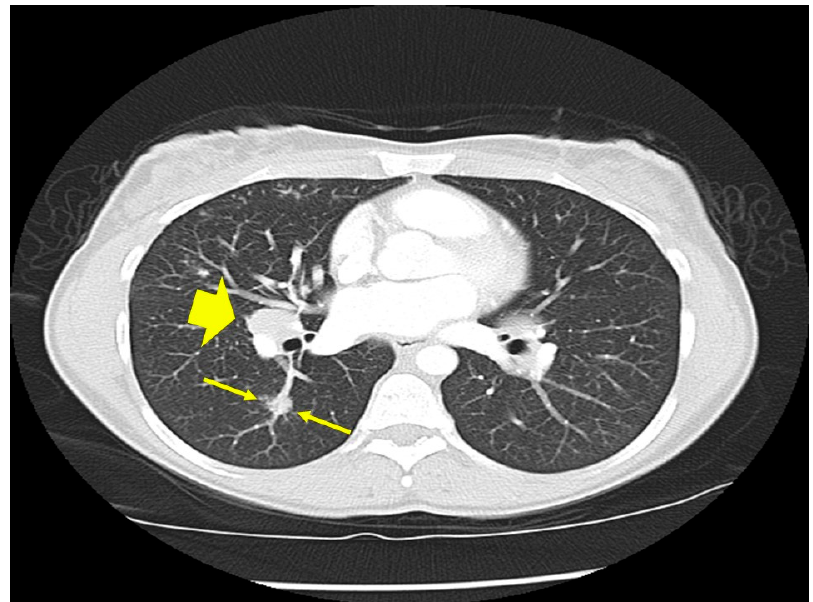
Figure 3. Chest CT scan image of a patient with pulmonary sarcoidosis demonstrating lung opacities from granulomatous inflammation around pulmonary vessels (thin arrows). Scatter parenchymal nodules and hilar adenopathy are seen, especially on the right (thick arrow).